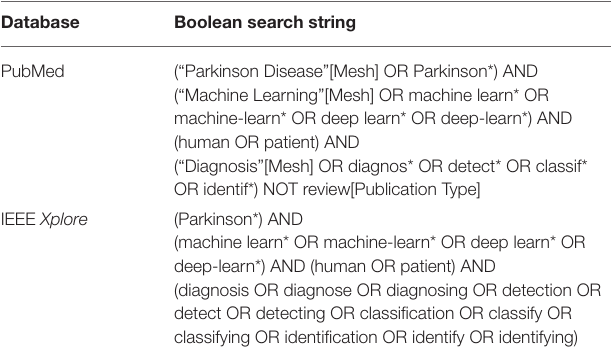
TABLE 1 | Boolean search strings used for the retrieval of relevant publications on PubMed and IEEE Xplore